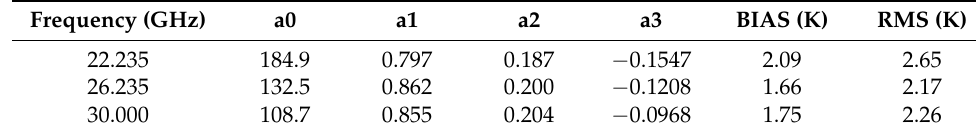
Table 1. Regression coefficients and BIAS and RMS of calculating T m a 0 , a 1 , a 2 , and a 3 are the regres- sion coefficients. The BIAS means the mean bias and the RMS means the root-mean-square error.